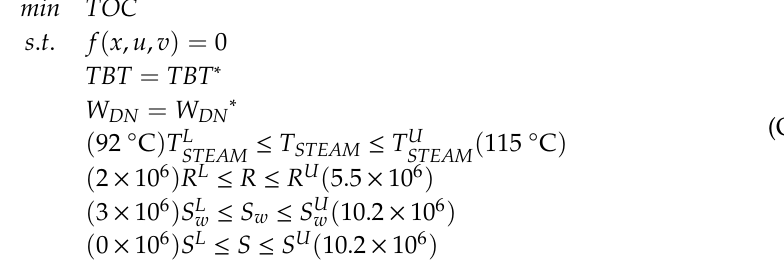
Figure 15. Trend chart of optimal operation parameters aiming at maximum GOR.